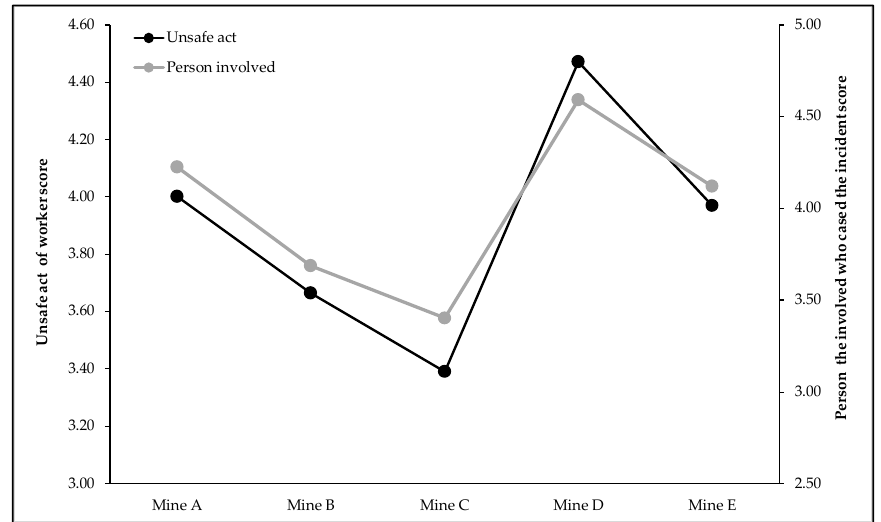
Figure 6. Scatter plot of the mean score for the unsafe act of workers and identify the person who caused the incident variables.